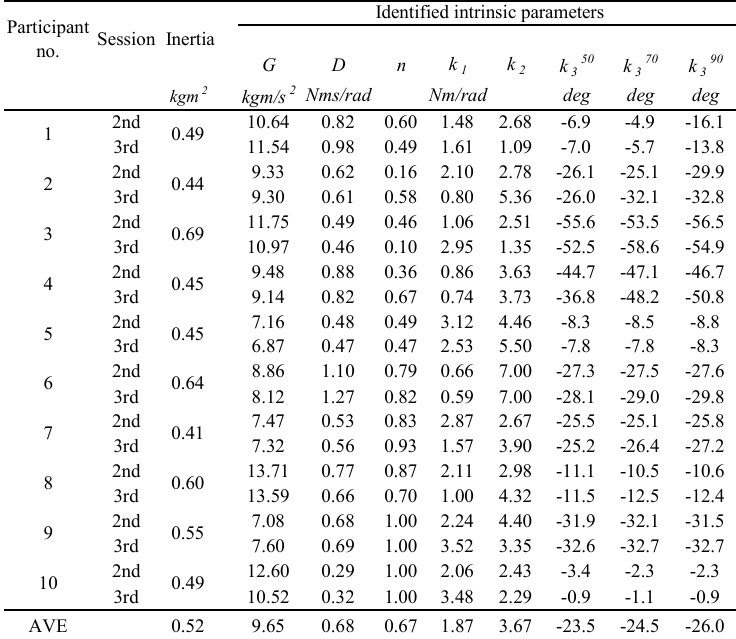
release angle. Identified k , which constrained the range of motion of the knee joint, showed 3 a significantly high correlation with the measured rest angle (r = -0.7; p < 0.001). Table 3. Identified intrinsic parameters of each session. The moment of inertia of each participant’s leg calculated from the regression equation is also given.